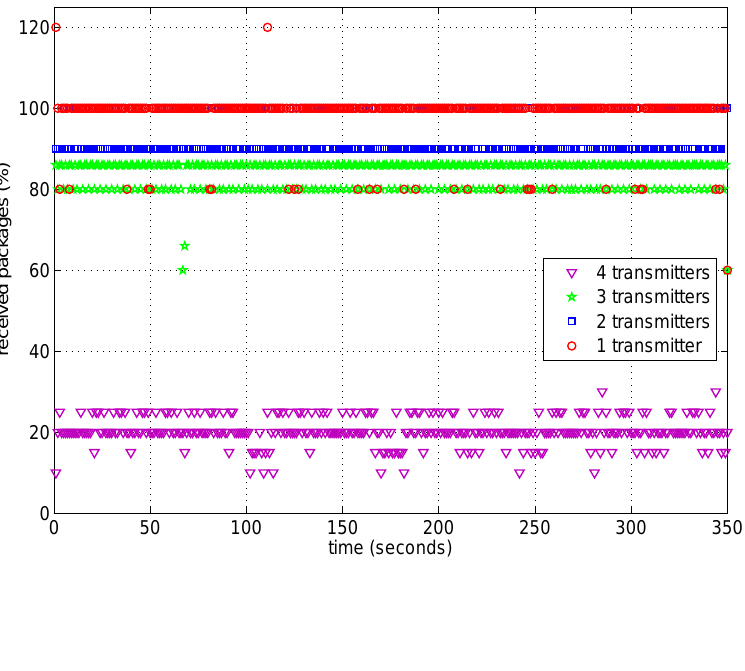
Figure 16. Receiving packets from several